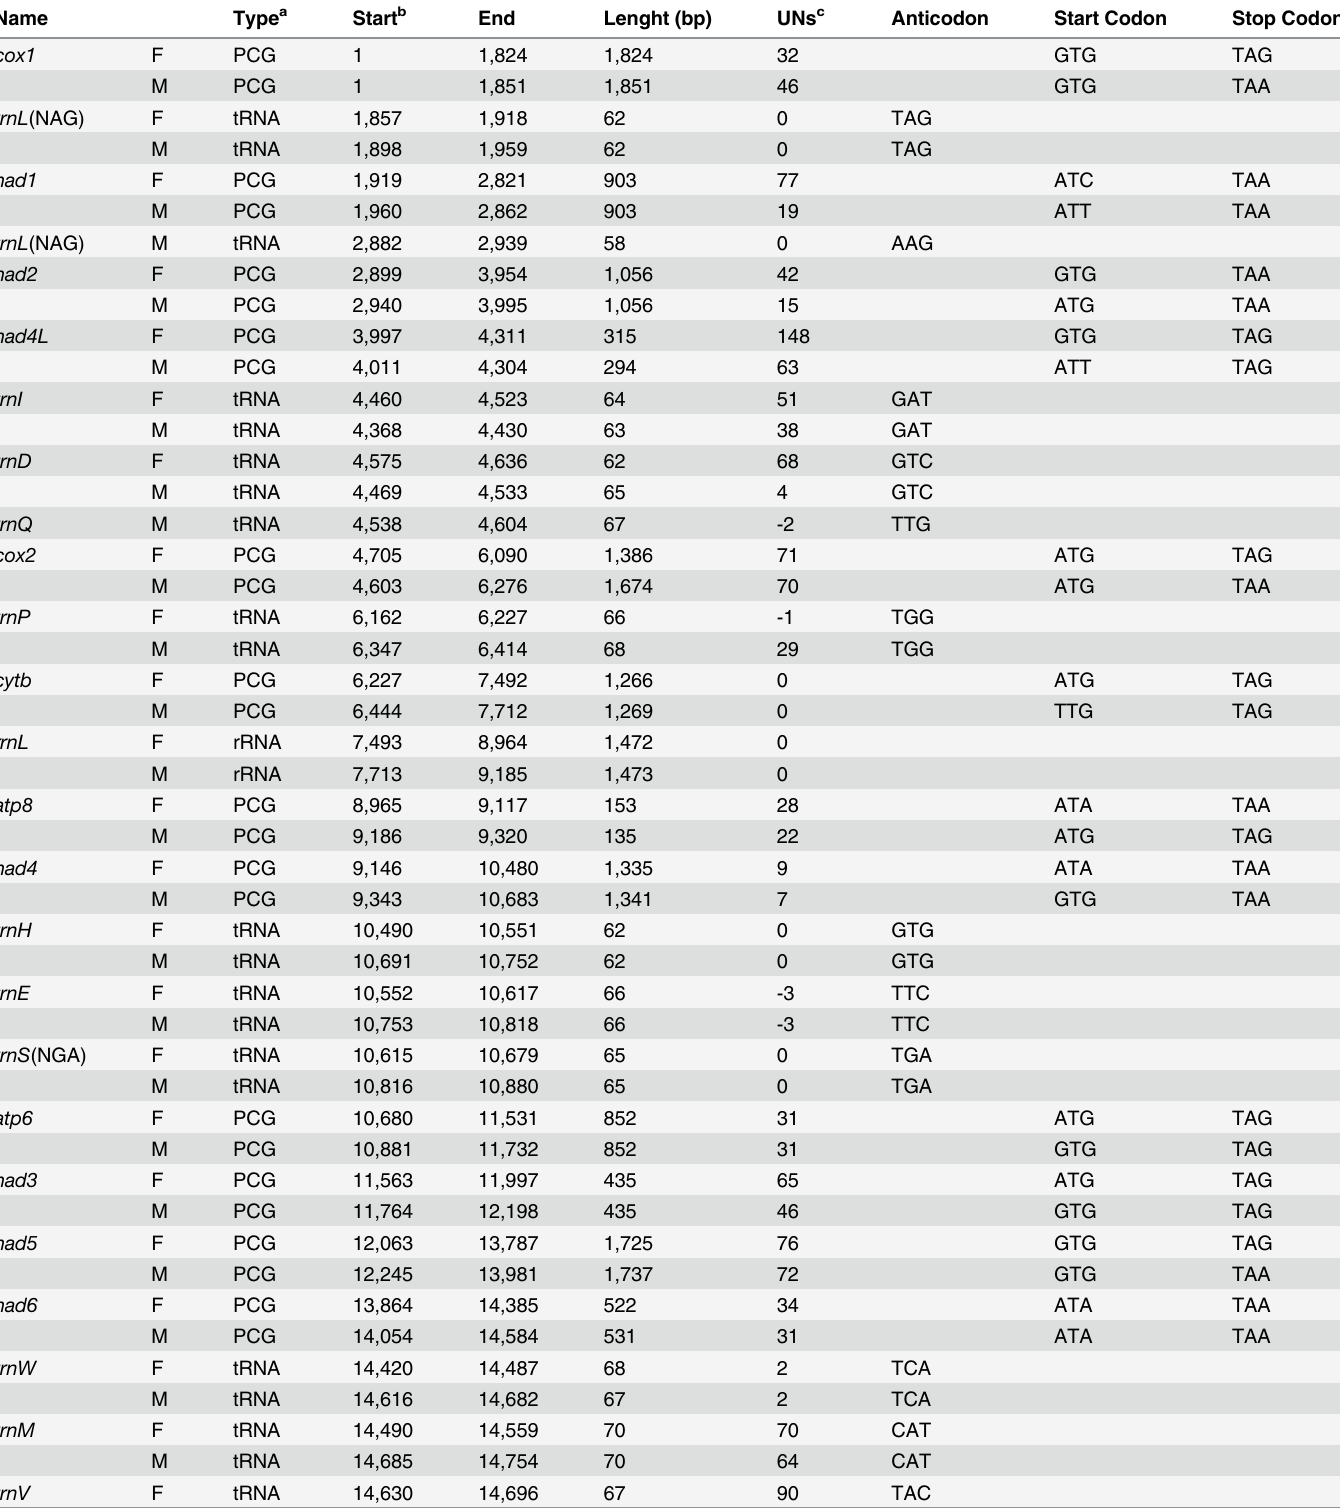
Table 1. Annotation of F and M mitochondrial genomes of Meretrix lamarckii